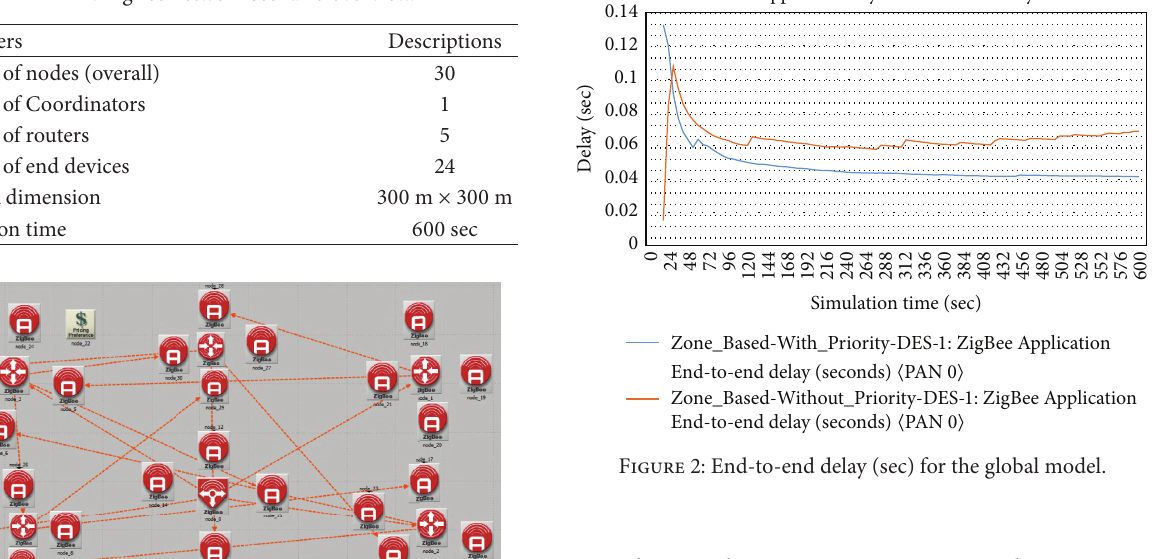
Table 2: ZigBee network scenario overview.